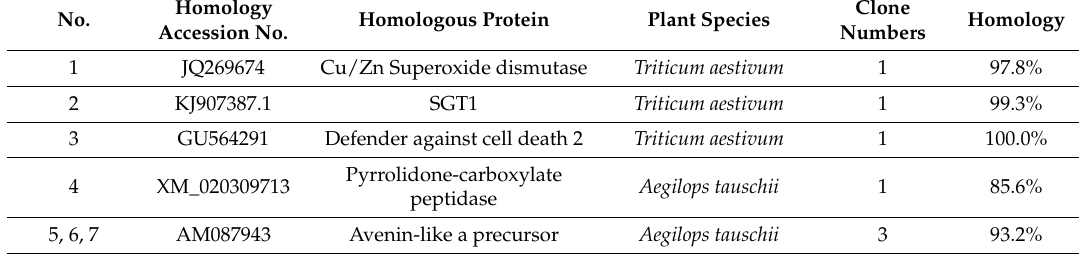
Table 2. The identified protein species with interaction with TaERFL1a protein via yeast two-hybrid screening.